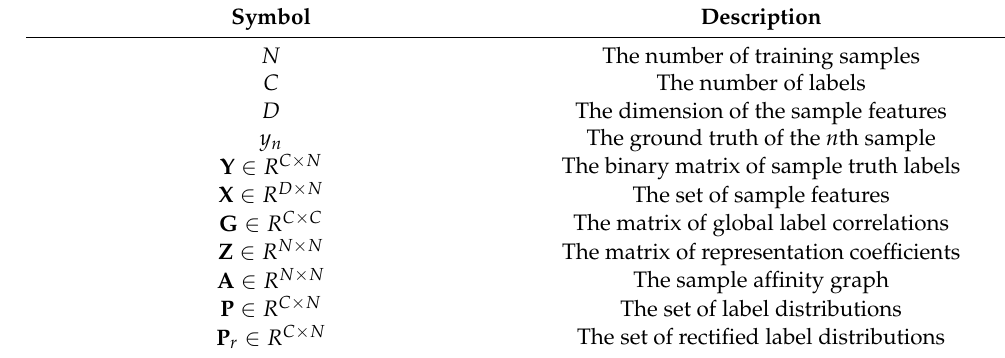
Table 1. Symbol descriptions. Symbol Description N The number of training samples C The number of labels D The dimension of the sample features y n The ground truth of the n th sample Y ∈ R C × N The binary matrix of sample truth labels X ∈ R D × N The set of sample features G ∈ R C × C The matrix of global label correlations The matrix of representation